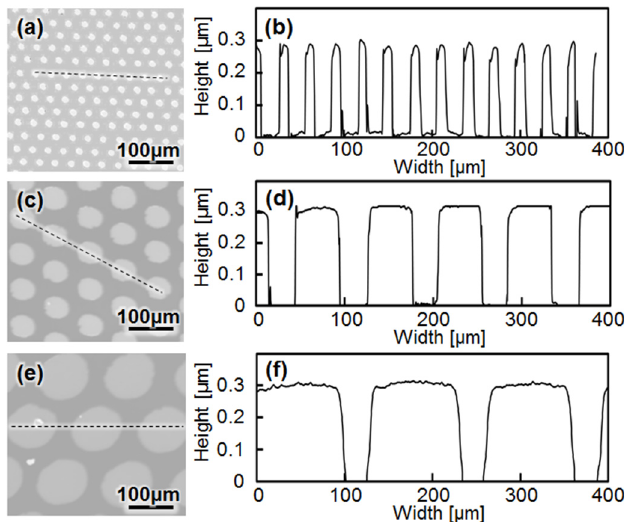
Fig. 4. Microscopic images of micro-textured DLC coatings and their surface pro fi le with a texture interspace of l inter =15 m m (a,b), 30 m m (c,d) and 50 m m (e,f) with a constant diameter of D =50 m m. Those dimensions are corresponding to the DLC coverage of 54, 35 and 23%, respectively.